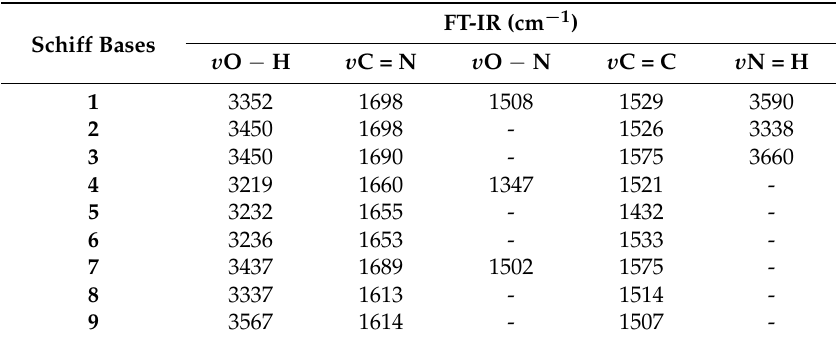
Table 2. The FT-IR spectral data of substituted Schiff bases ( 1 – 9